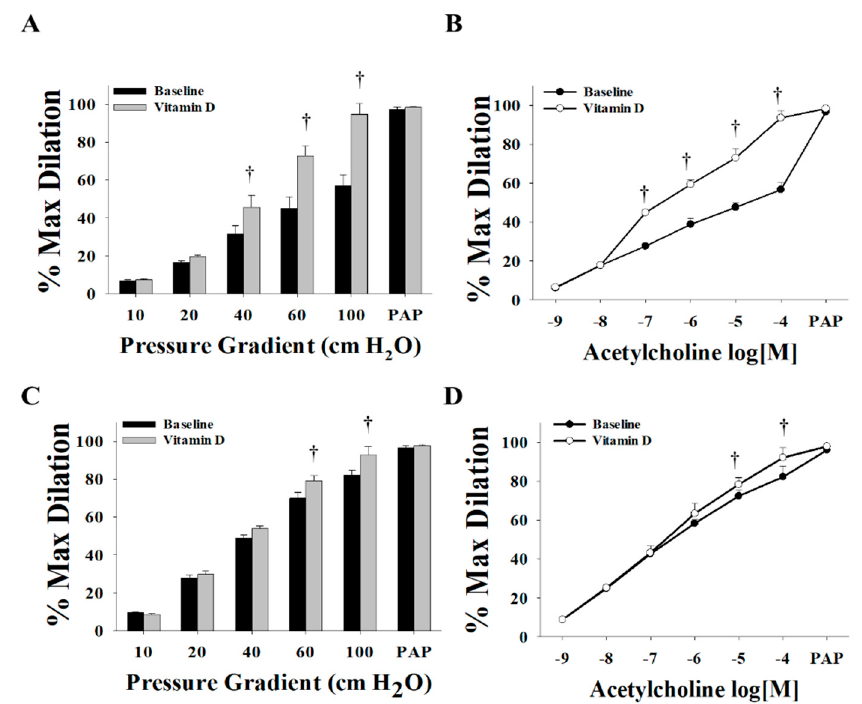
Figure 2. Effect of vitamin D on flow-induced dilation (FID) and acetylcholine-induced dilation (AChID) in adipose tissue resistance arterioles collected on the day of surgery ( n = 15 subjects). FID measurements in visceral adipose tissue (VAT) arterioles ( A ) and subcutaneous adipose tissue (SAT) arterioles ( C ) corresponding to increasing intraluminal pressure gradients of 10 – 100 cm H 2 O. AchID measurements in VAT arterioles ( B ) and SAT arterioles ( D ) corresponding to increasing concentrations of acetylcholine (Ach) (10 − 9 to 10 − 4 M). All measurements are presented as means ± standard error (SE); † p < 0.05 comparing vitamin D with baseline.